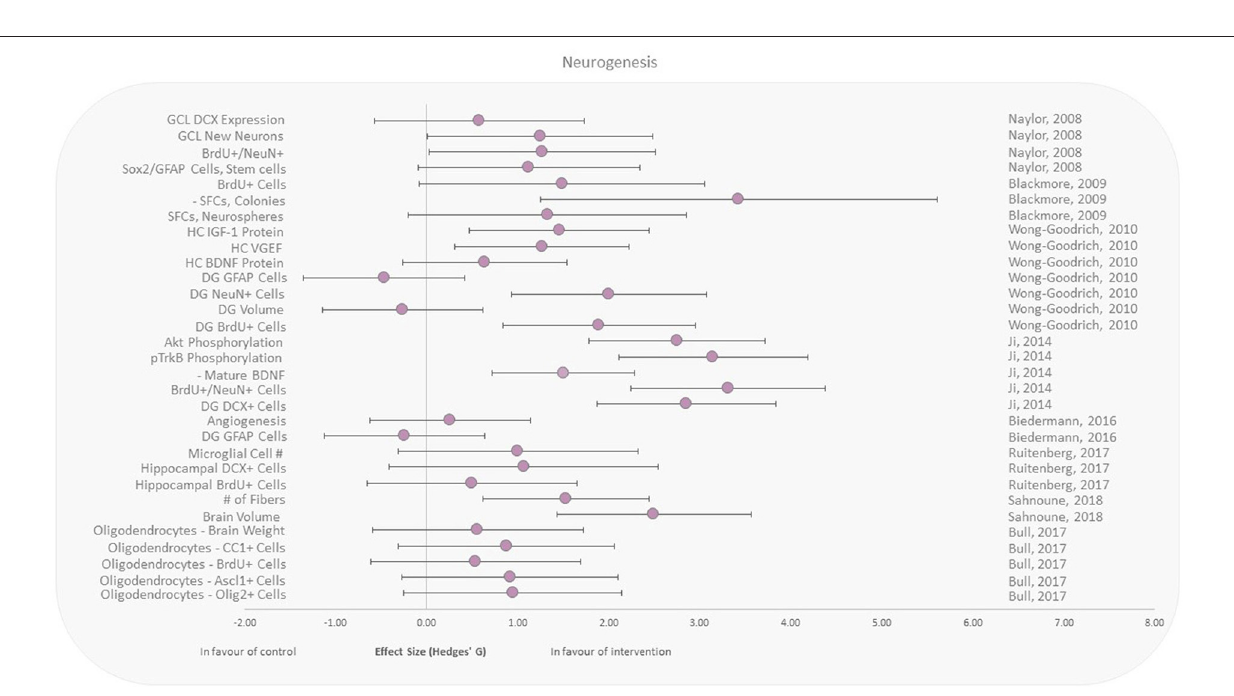
FIGURE 4 | Effect size plot of neurogenesis in animal studies. Outcomes are plotted with the Hedges’ g calculated for each outcome extracted and bias corrected for sample size. Confidence intervals of 95% are represented by the error bars. Effect size values that are in the positive rightward direction indicate a beneficial effect in favor of the exercise intervention group compared to the non-exercise control group. Shapes refer to the time at which the exercise intervention was applied with respect to the radiation exposure